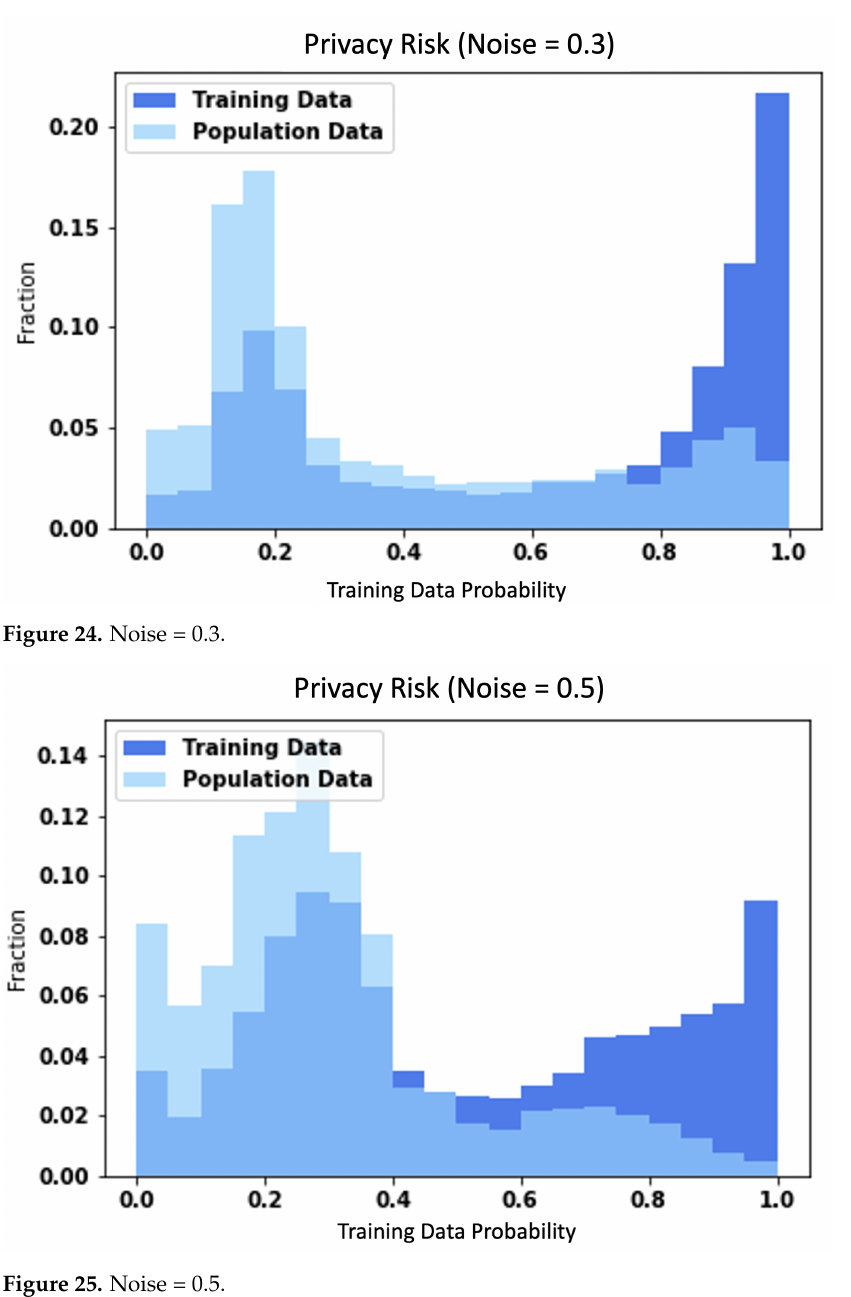
Figure 25. Noise =